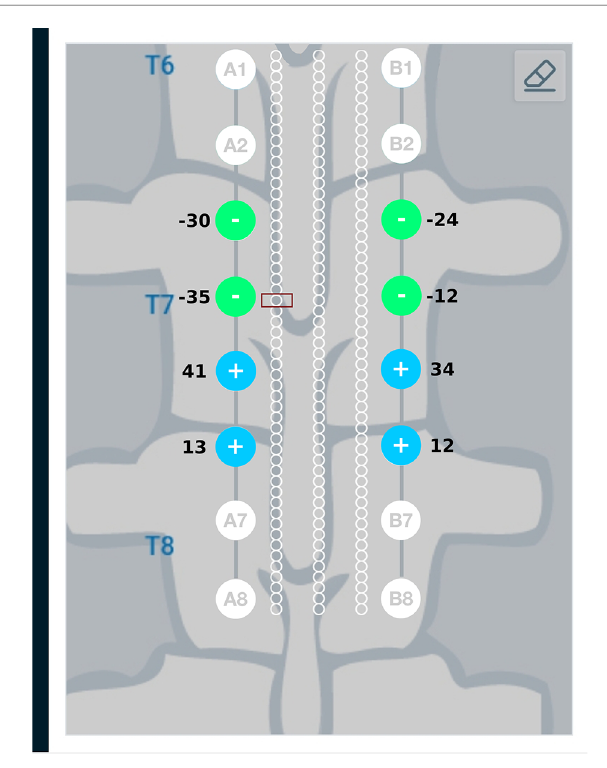
FIGURE 12 FIGURE 13 Current steering results graphically represented on the user interface. For Current steering results graphically represented on the user interface. The the target region located relatively closer to lead A, the optimal electrode staggered con fi guration shown in this fi gure has the 1st electrode on one excitation shows that the current sourced from lead A is more than lead B. lead in front of the 2nd electrode on the other lead. The target region is considered at an equal distance from both the leads. As the target region is directly in front of lead A, the current steering method gives a solution where more electrodes from lead A are active. Electrodes A1, Figure 13 shows the graphical A2, A3, B1, B2 which are closer to the target region are